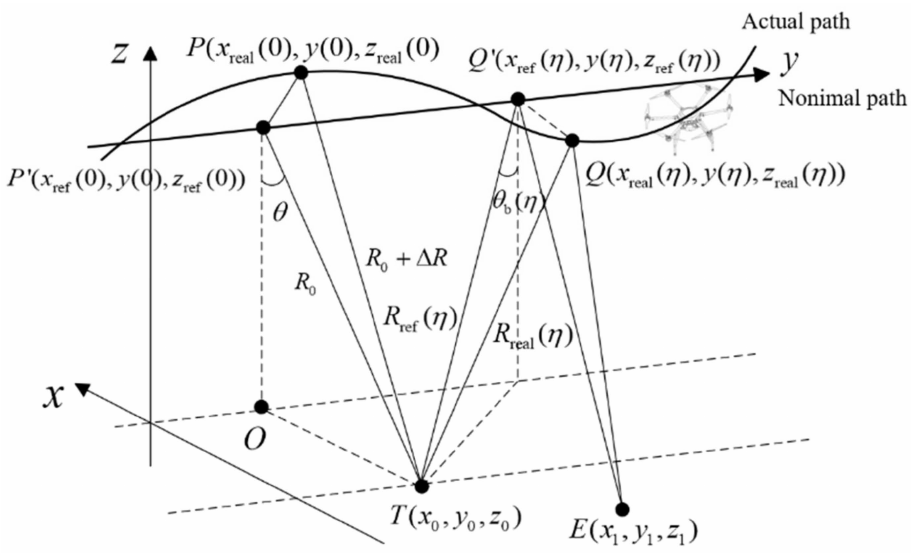
Figure 1. Geometric diagram of airborne